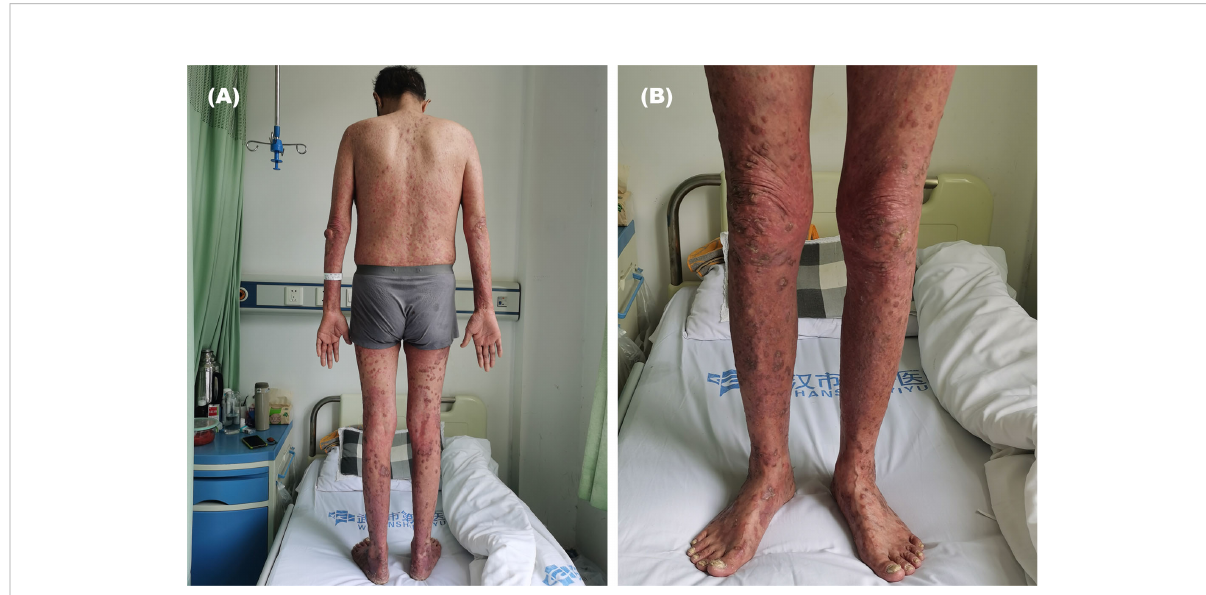
FIGURE 1 Psoriasis exacerbated during the 6th course of anti-programmed cell death 1 (PD-1) (camrelizumab), which characterized by skin lesions expanding on both hands, legs, and trunk. ( A , back of the whole body), ( B , front of the